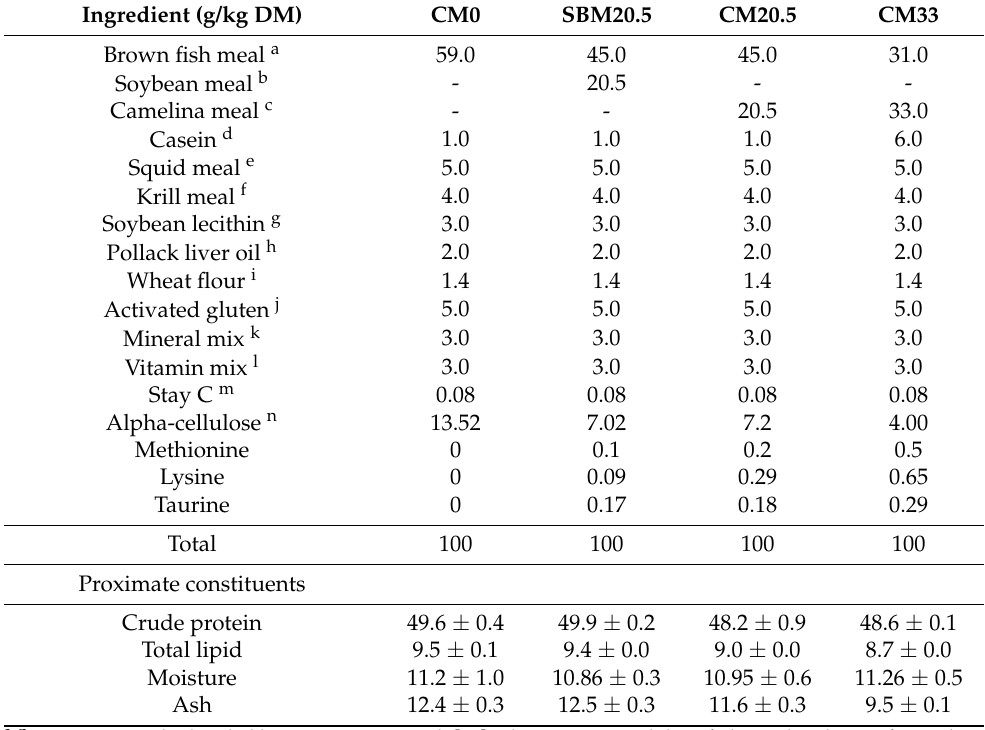
Table 1. The proportion of ingredients (g/kg) and chemical composition (%) of experimental diets. Ingredient (g/kg DM)